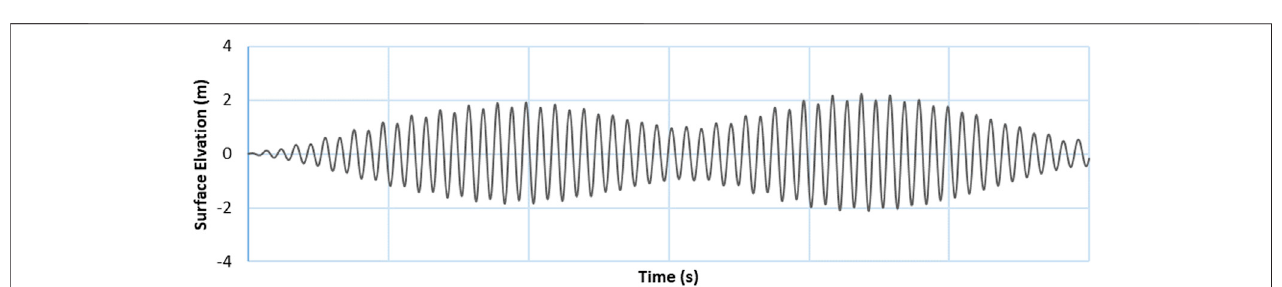
FIGURE 6 | Surface elevation pro fi le of alderney race with the friction coef fi cient of 0.0025.